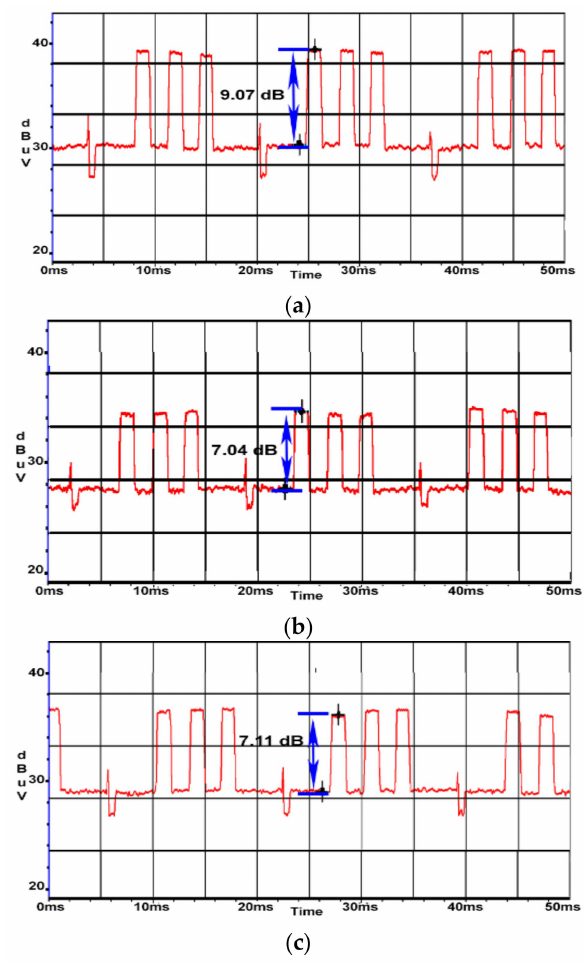
Figure 20. AOC display: ( a ) SNR measured for display’s power cable with no ferrites (SNR = 9.0 dB); ( b ) SNR measured for display’s power cable with ferrite TDK SEIWA 18 mm ferrite at the IEC C13 end (SNR = 7.0 dB); ( c ) SNR measured for display’s power cable with ferrite TDK SEIWA 18 mm ferrite at the schuko end (SNR = 7.1